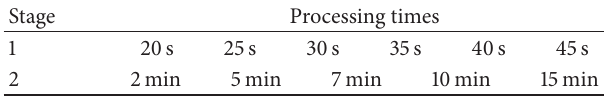
Table 2: Processing time combinations between stage 1 and stage